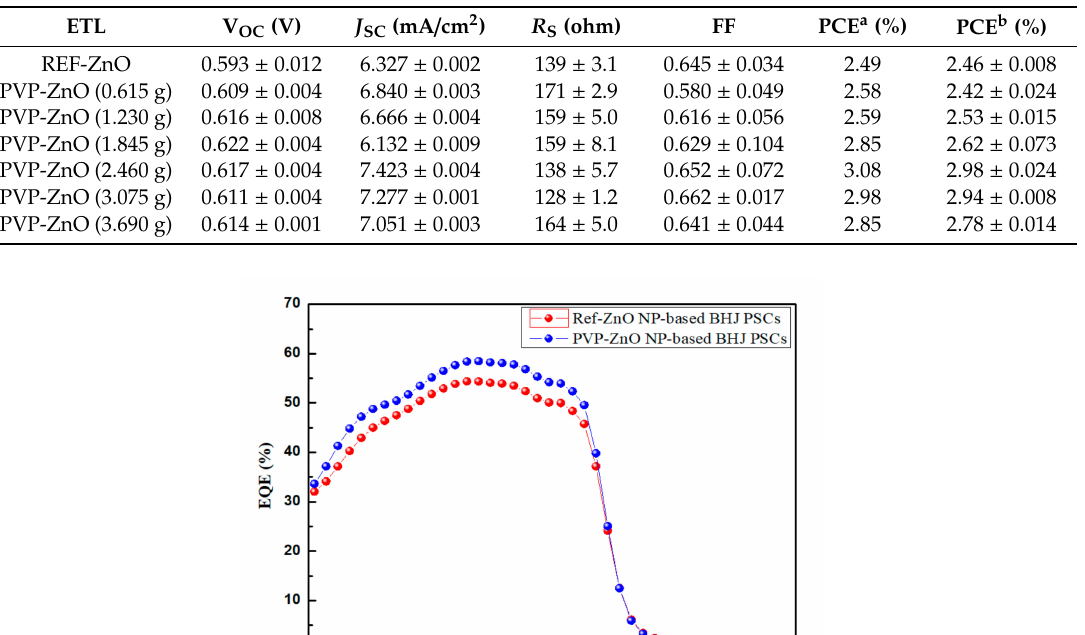
Table 2. Photovoltaic performance parameters of BHJ-PSCs fabricated with ZnO and PVP-capped ZnO in di ff erent PVP:Zn ratios. PCE a and PCE b are best and average power conversion e ffi ciencies (PCEs) of devices.